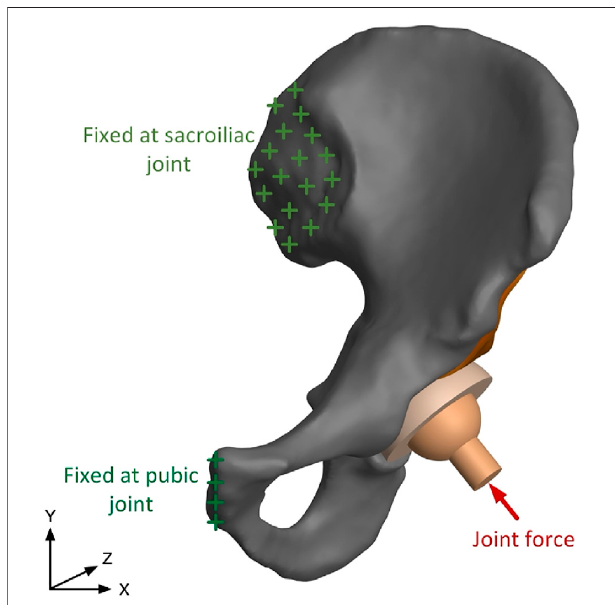
FIGURE 3 | Assembly model of the human left pelvis and boundary